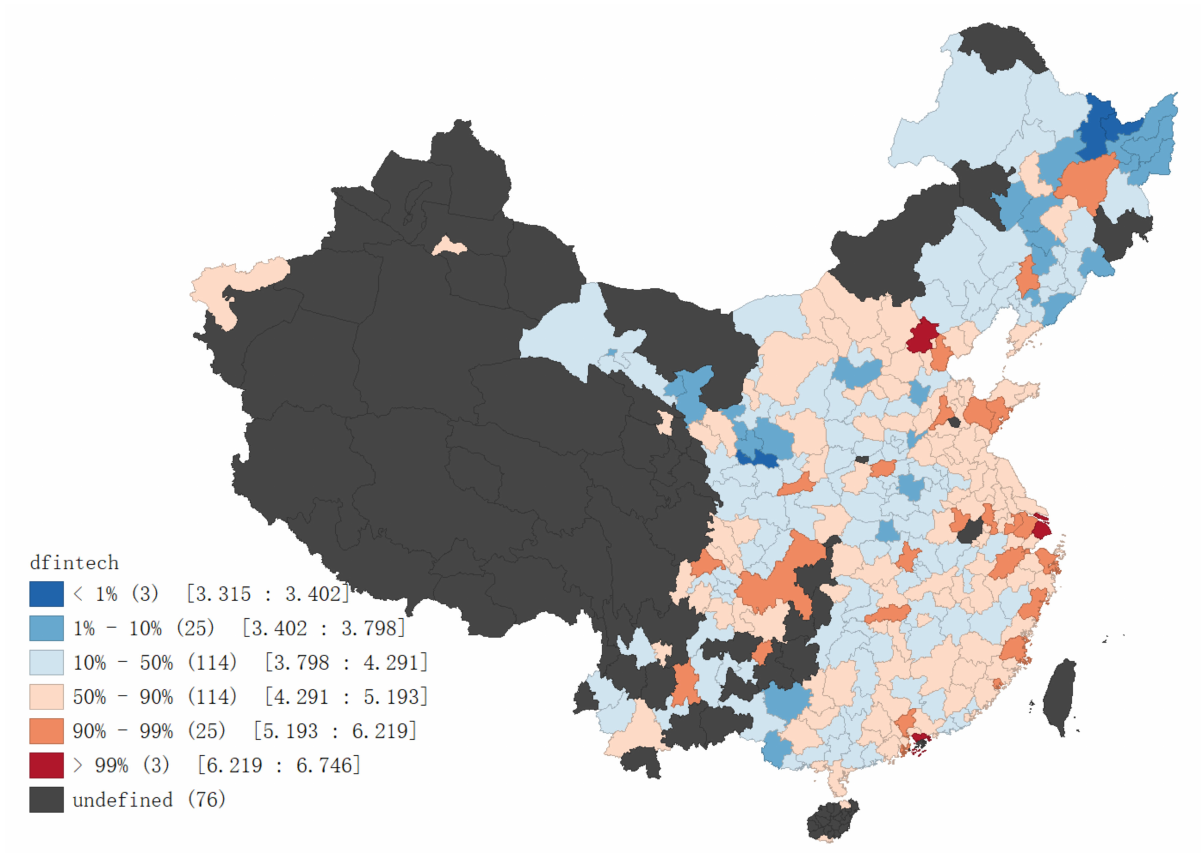
Figure 3. Mean d-fintech values from 2008 to